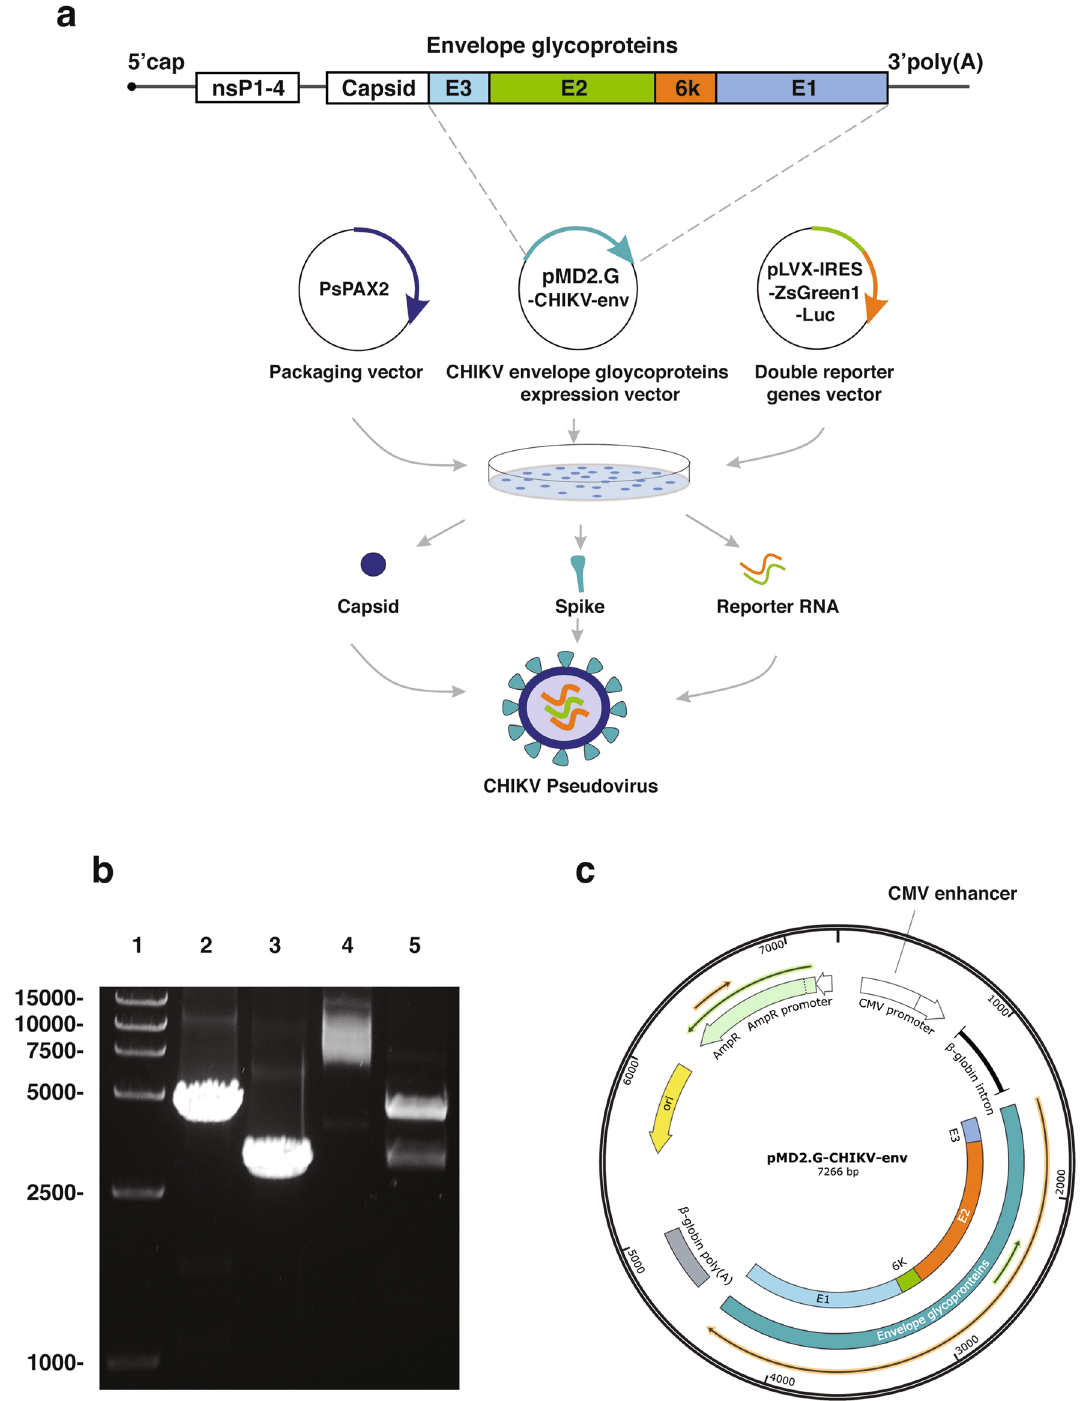
Figure 1. Construction of the CHIKV PsV. ( a ) The CHIKV PsV construction scheme. Each gene fragment was indicated by the colored box. ( b ) Construction and identification of the pMD2.G-CHIKV-env. Primers for PCR were described in the “Materials and methods” section. 5 ul of each product was analyzed in 0.8% agarose gel. Lane 1, DNA marker; Lane 2, linearized pMD2.G-ΔVSV-G backbone (4295 bp); Lane 3, CHIKV envelope gene (2995 bp); Lane 4, undigested pMD2.G-CHIKV-env plasmid (7266 bp); Lane 5, pMD2.G-CHIKV-env plasmid digested by AscI and Xbal (2967 bp and 4299 bp). ( c ) Map of the recombinant plasmid pMD2.G-CHIKV-env that was illustrated by the software SnapGene Viewer (CA,